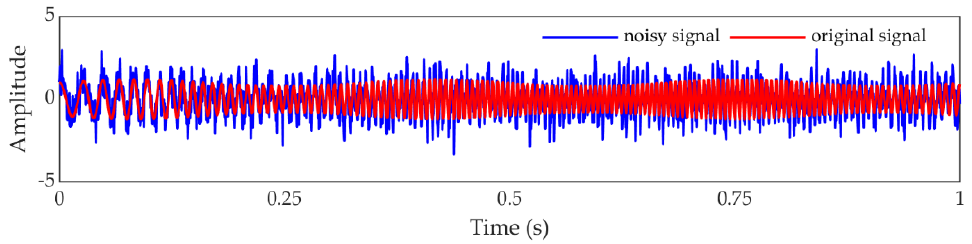
Figure 1. The original and noisy signal.